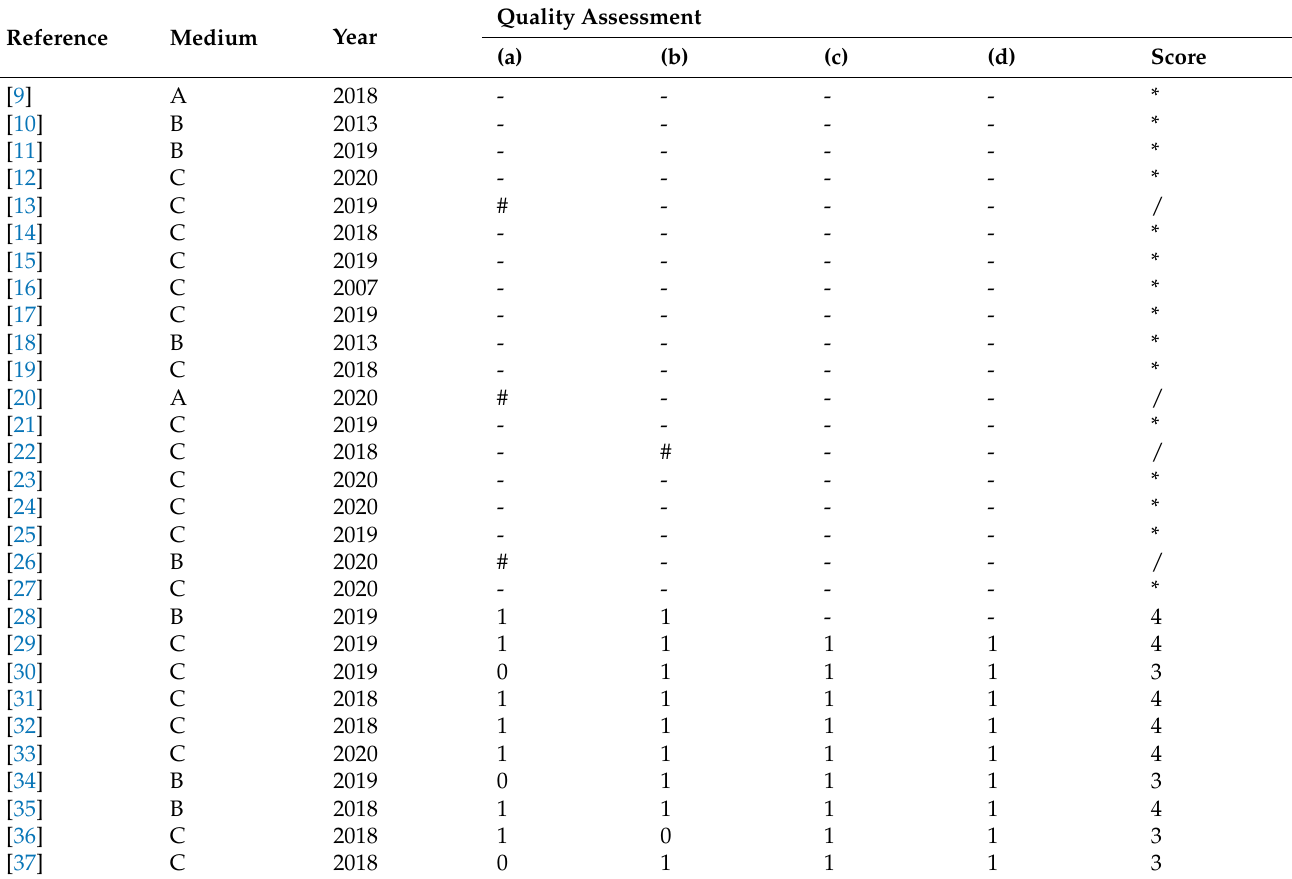
Table 6. The quality assessment of the